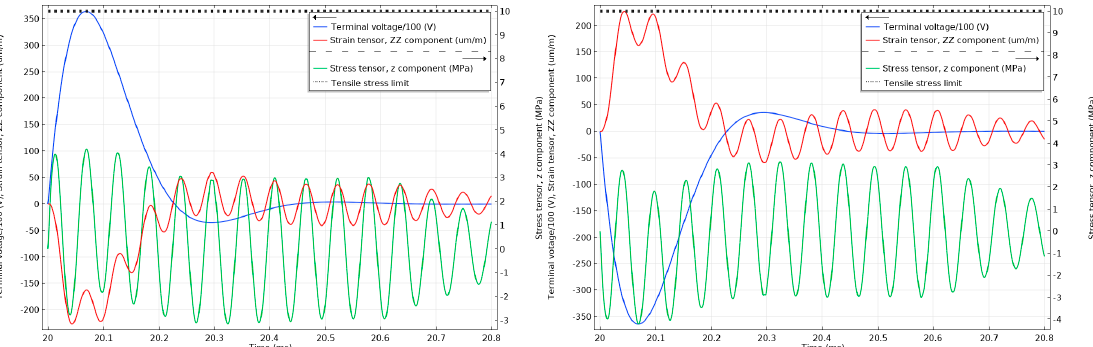
Figure 17. Stress and strain in the undamped stack when subjected to attenuated 60 kV positive ( left ) and negative ( right ) lightning impulses. The tensile stress limit of 10 MPa is marked by a black dotted line. (The terminal voltage is the voltage applied to the top electrode of the stack.).